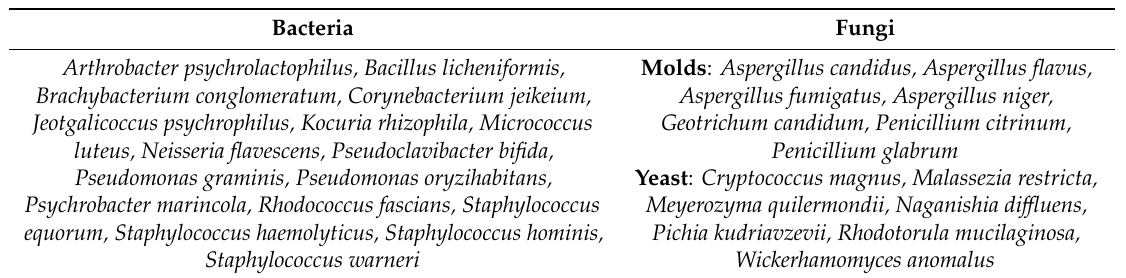
Table S1. Biodiversity of bacteria in the samples—high-throughput sequencing; Table S2. Biodiversity of fungi in the samples—high-throughput